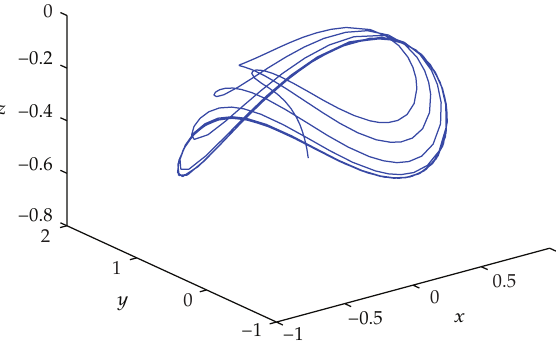
Figure 6: Phase diagram for system (cid:5) 2.2 (cid:6) with c (cid:7) − 0 .